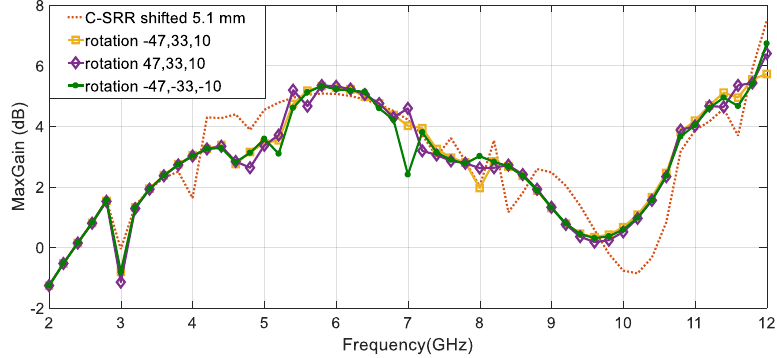
Figure 33. Maximum gain of the antennas.